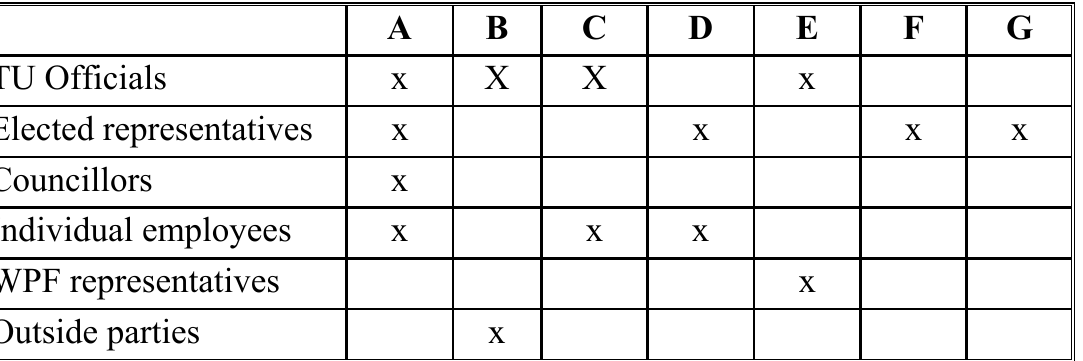
TU/worker representatives(cid:146)